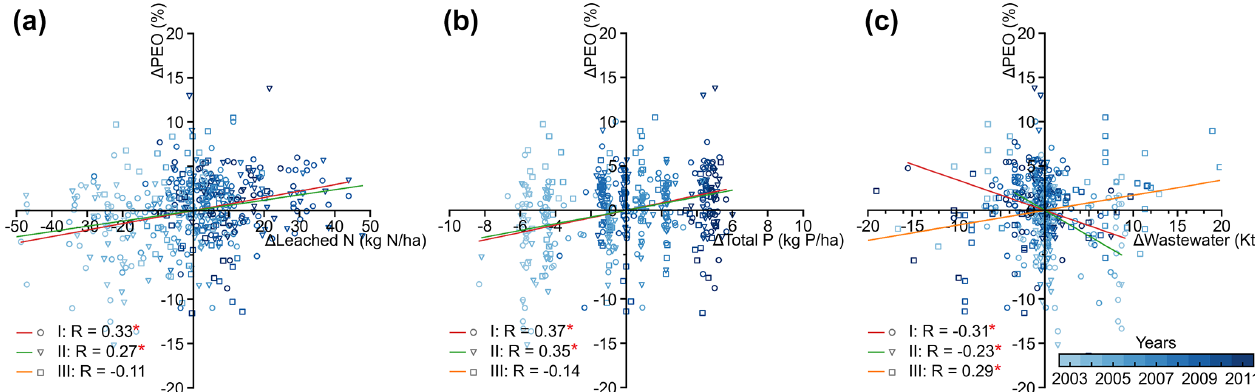
Figure 8. Relationships between the annual anomalies of PEO and nitrogen leaching (a) , total phosphorus sources (b) , and industrial wastew- ater discharge (c) for 50 studied lakes. The color and symbol of scattering points represent the years and lake classes, and the colored lines (shown for significant correlations only) are linear regressions between the annual anomalies of PEO and nutrient-related variables for each lake class. Significant correlation coefficients are marked by the red stars “ ∗